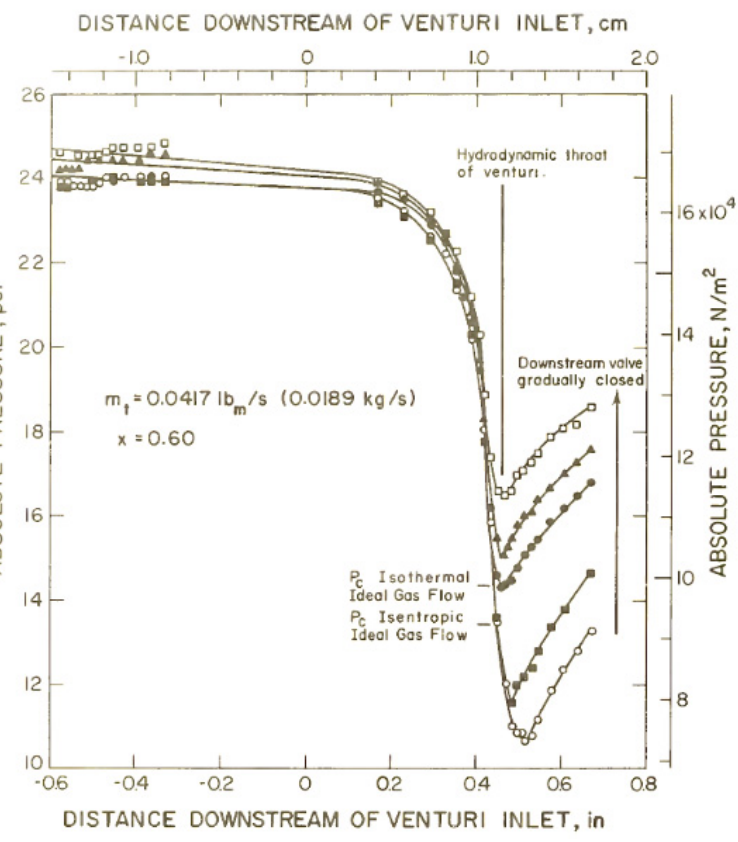
Figure 25. Downstream pressure distribution in Venturi system [88].